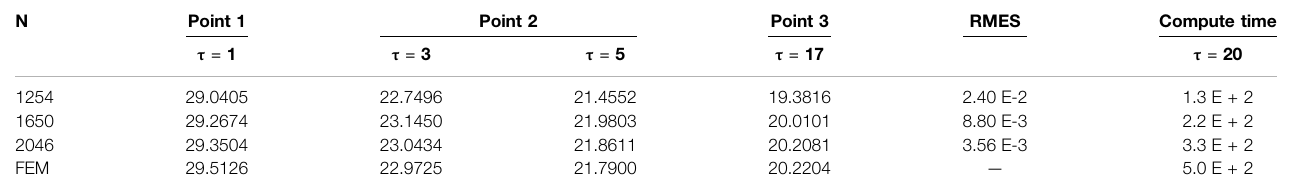
TABLE 6 | RMSE of numerical solution and re fi ne solution varies with time under different fi eld nodes, for Example four. N Point 1 Point